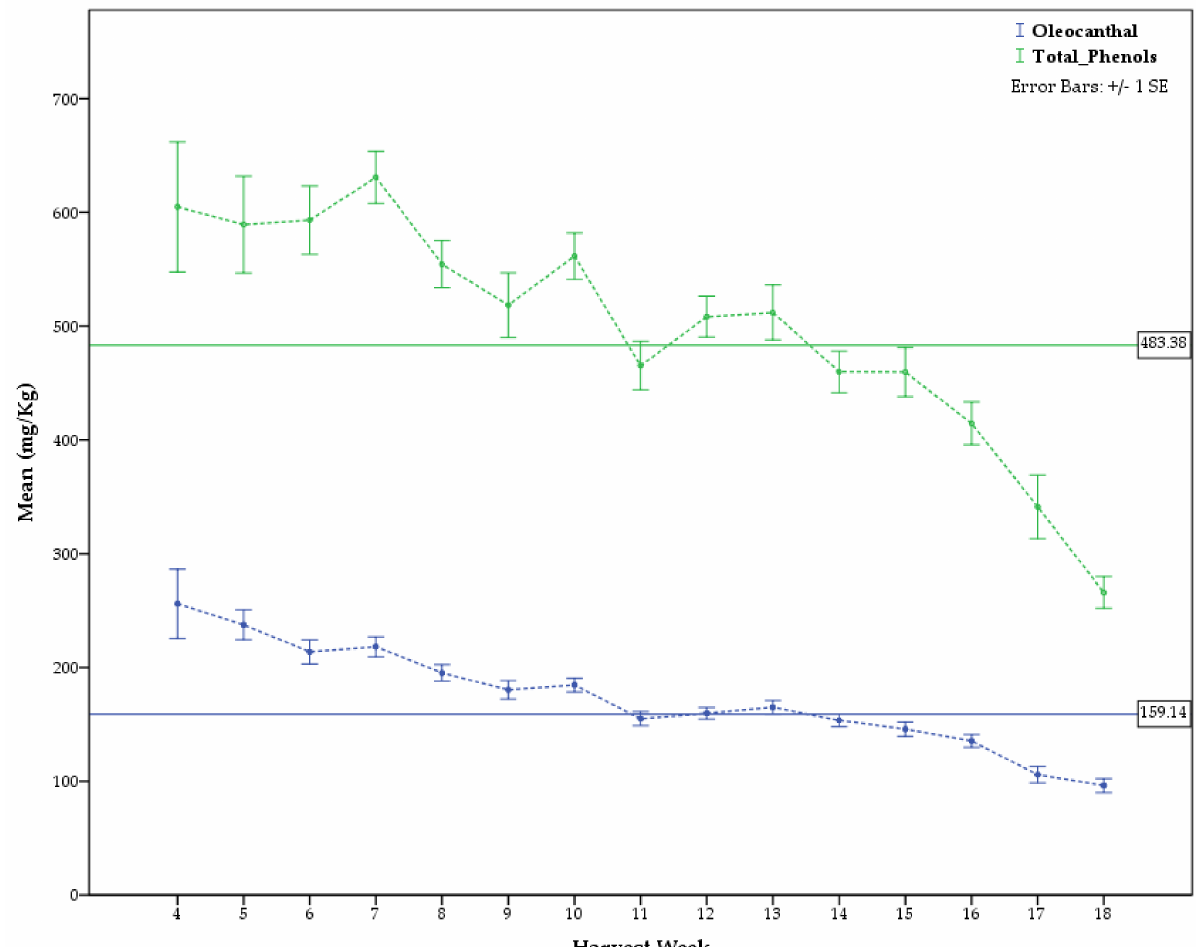
Figure 6. Difference in concentration of oleocanthal and total phenols in relation to harvest